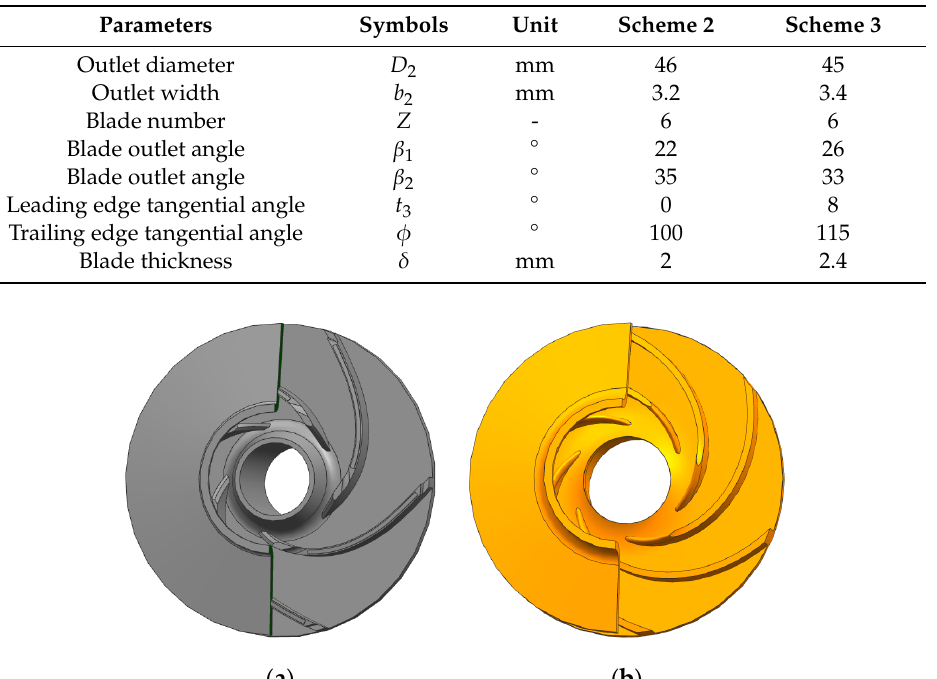
Table 11. Comparison of geometric parameters between scheme 2 and scheme 3.